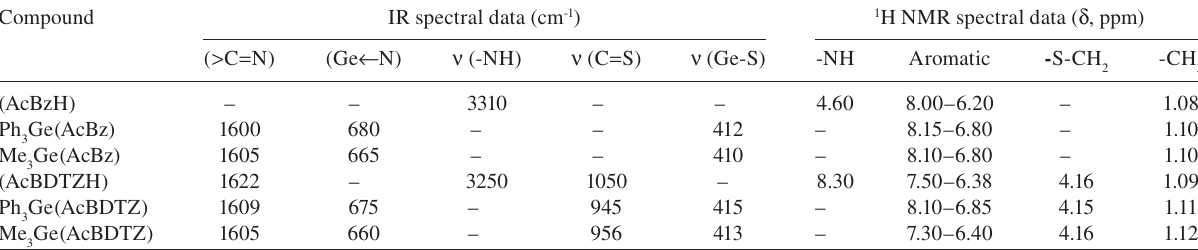
Table 1 IR (cm -1 ) and 1 H NMR ( δ , ppm) spectral data of the ligands and their corresponding complexes.